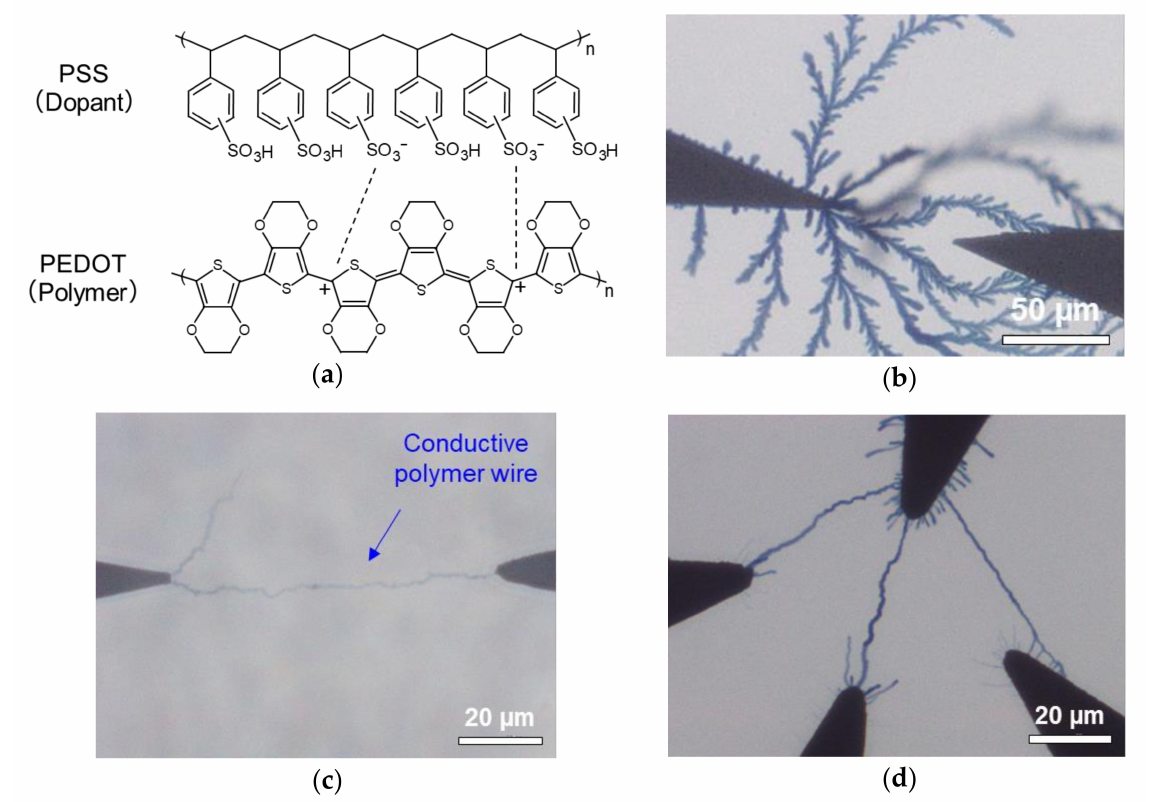
Figure 1. ( a ) Molecular structure of poly(3,4-ethylenedioxy-thiophene) doped with poly(styrene sulfonate) anions (PE- DOT:PSS) conductive polymer. ( b ) Dendritic and ( c ) wire- shaped PEDOT:PSS obtained via electrodeposition. ( d ) Network circuit formed via branch wiring of PEDOT:PSS polymer between four